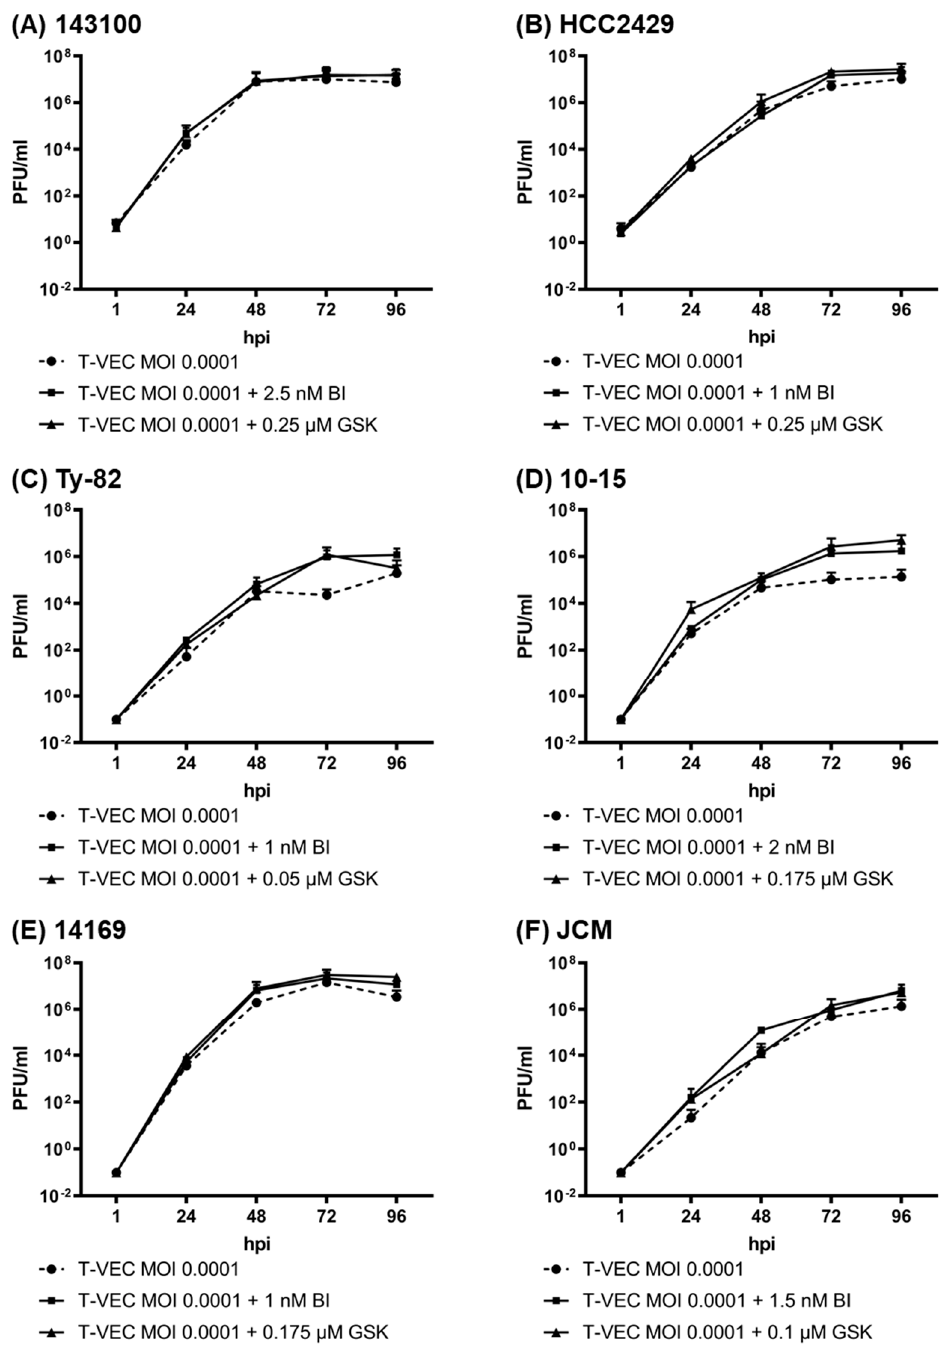
Figure 6. Viral replication of T-VEC in NC cell lines alone and after combination with either BET inhibitor (iBET) BI894999 (BI) or GSK525762 (GSK): 143100 ( A ), HCC2429 ( B ), Ty-82 ( C ), 10-15 ( D ), 14169 ( E ), and JCM ( F ) tumor cells were infected with T-VEC at a multiplicity of infection (MOI) of 0.0001 alone or in combination with BI or GSK at cell line-adjusted concentrations. Viral replication was analyzed via plaque assay at 1, 24, 48, 72, and 96 h post infection (hpi). As expected, viral titers increased substantially, with a more rapid time to plateau in NC cell lines with higher susceptibility to the virus. In general, the maximum viral titers that were reached in cells with T-VEC monotherapy were between 10 6 and 10 7 plaque-forming units (PFU)/mL for all tested NC cell lines, indicating a high susceptibility of all six NC cell lines to T-VEC infection. Thereby, a correlation between the reduction in viable